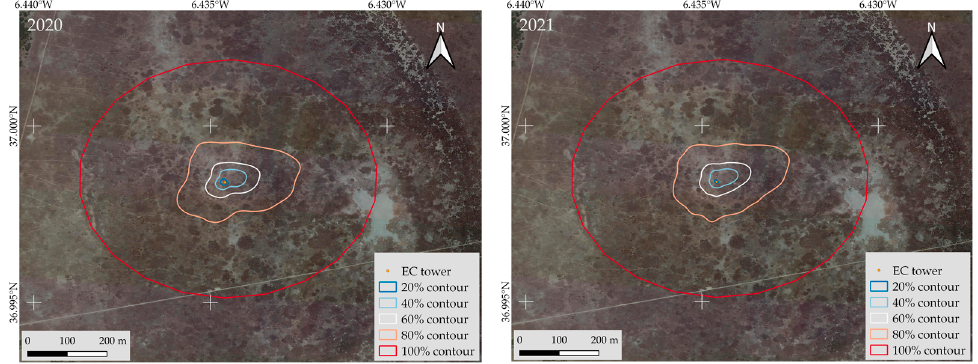
Figure 4. Climatological footprint of 2020 ( left image ) and 2021 ( right image ).